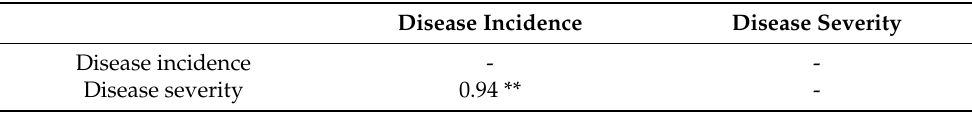
Table 4. Main and interaction effects of different coating treatments and storage days on